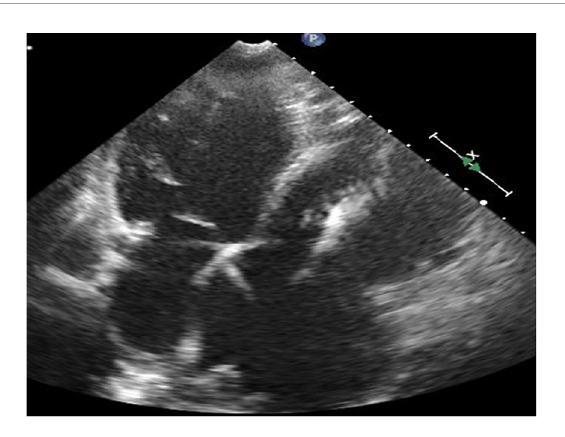
FIGURE4 Four-chamber view at end-systolic phase of transthoracic echocardiography in Case 2. Note that the tricuspid valve does not close at all, and the right atrium is hugely dilated.